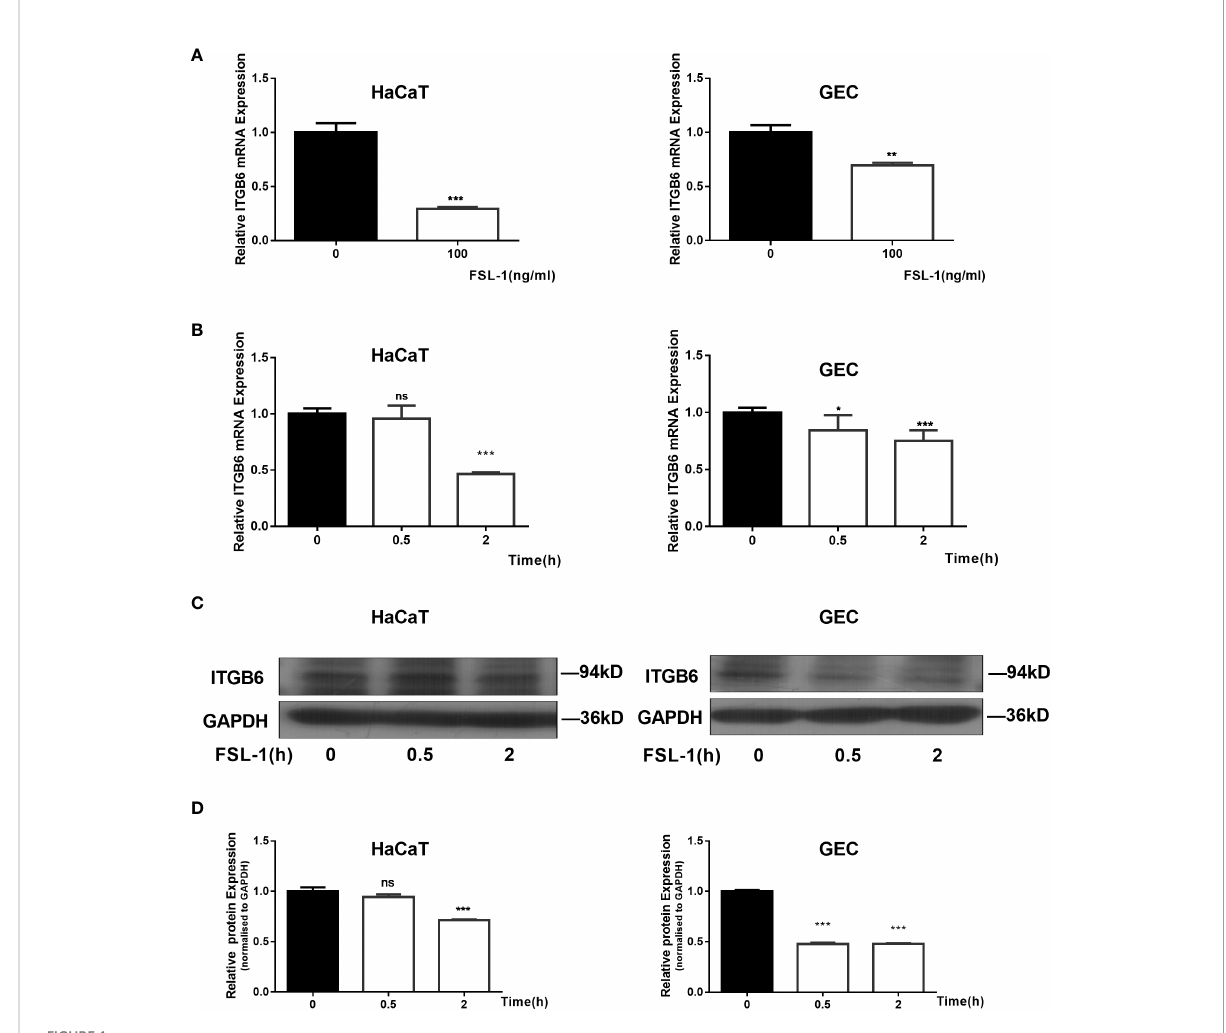
FIGURE 1 Suppression of ITGB6 by FSL-1 in human epithelial cells. (A) HaCaT (Left) or GECs (Right) were treated with 100 ng/mL FSL-1 for 2 h. ITGB6 mRNA were then extracted, and the mRNA levels were measured by qRT-PCR. (B) HaCaT (Left) or GECs (Right) were treated with 100 ng/ml FSL-1 for indicated times, and the ITGB6 mRNA expression levels were detected by qRT-PCR. (C) HaCaT or GECs were treated with 100 ng/mL FSL-1 for indicated times and the protein levels were assessed using western blotting. (D) Densitometric analysis was used to quantify protein bands. Data are presented as mean ± SEM from triplicates. no signi fi cance (ns), *P < 0.05, **P < 0.01, ***P < 0.001, comparison with time zero medium control